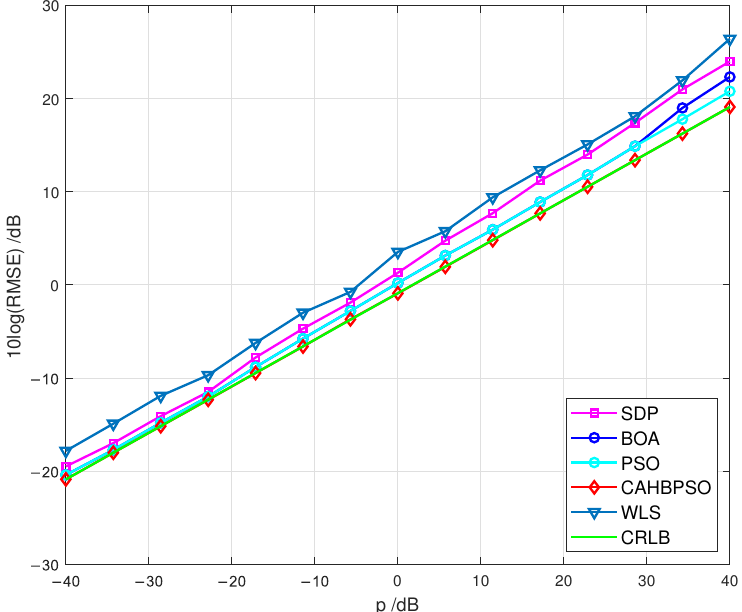
Figure 8. RMSEs in relation to measurement noise p for a third simulation